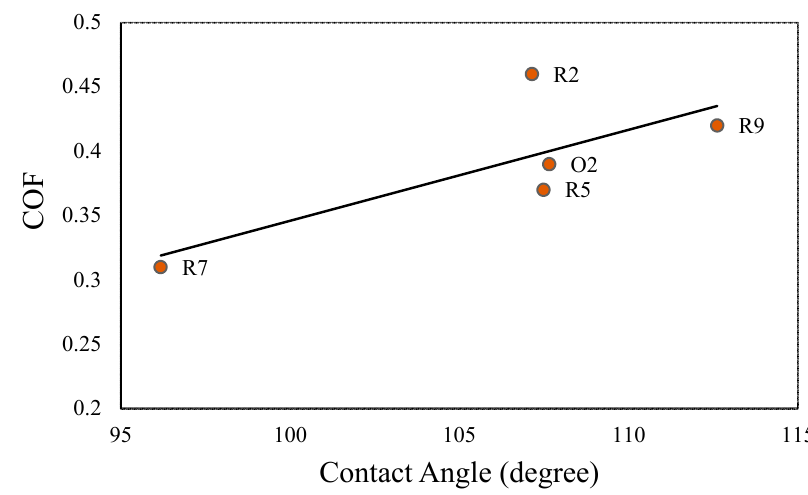
Figure 8. COF vs. CA for hydrophobic tile samples.